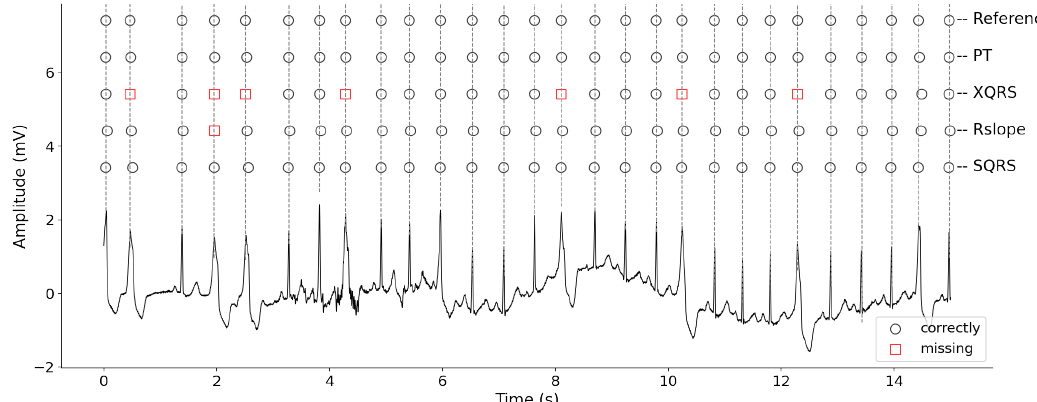
Figure 6. The R-peak detection results of 208 record for different detectors (a red rectangle is the missing R-peak). TP—true positive (correctly identified R peak); FN—false negative (missing R peak); FP—false positive (wrongly identified R peak); SEN—sensitivity; PPV—positive predicative value; CSI—cumulative statistical